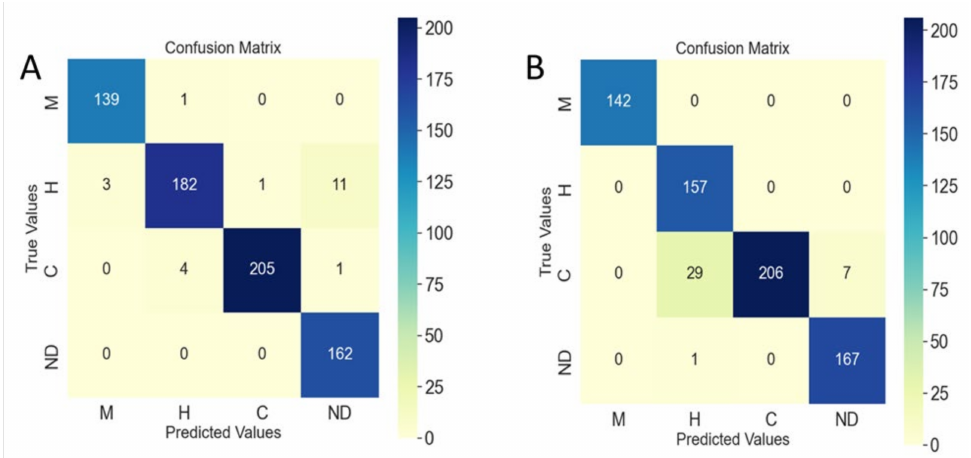
Figure 11. Confusion Matrix: ( A ) EfficientNet-B5-pro; ( B ) EfficientNet-B5. “M” = melanose; “H” = healthy; “C” = canker; “ND” = nutritional